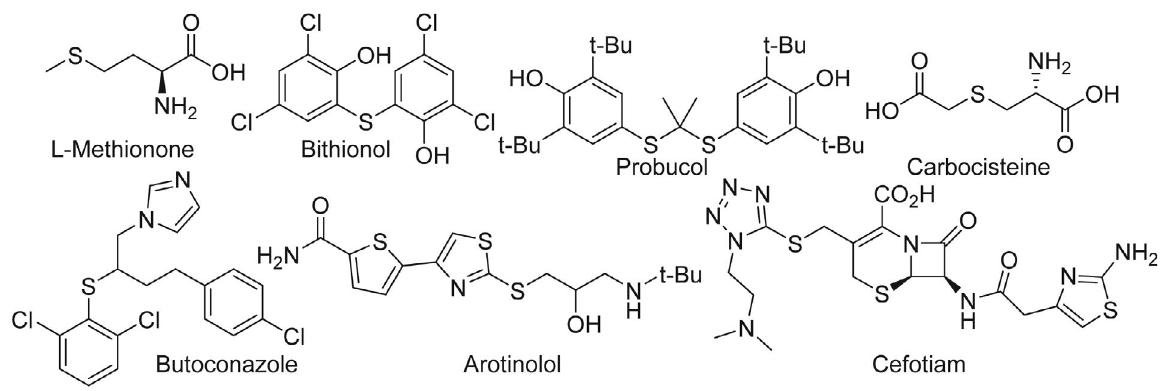
Figure 1. Some approved thioether-based drugs